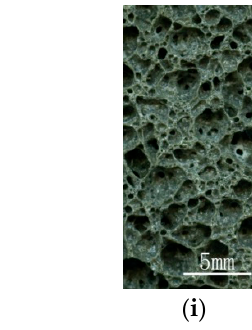
Table 4. The results of statistical analysis of the aperture in foam glass.